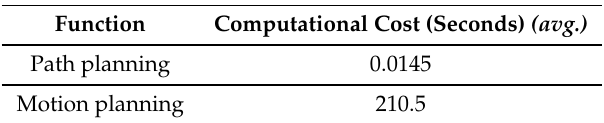
Table 6. Execution